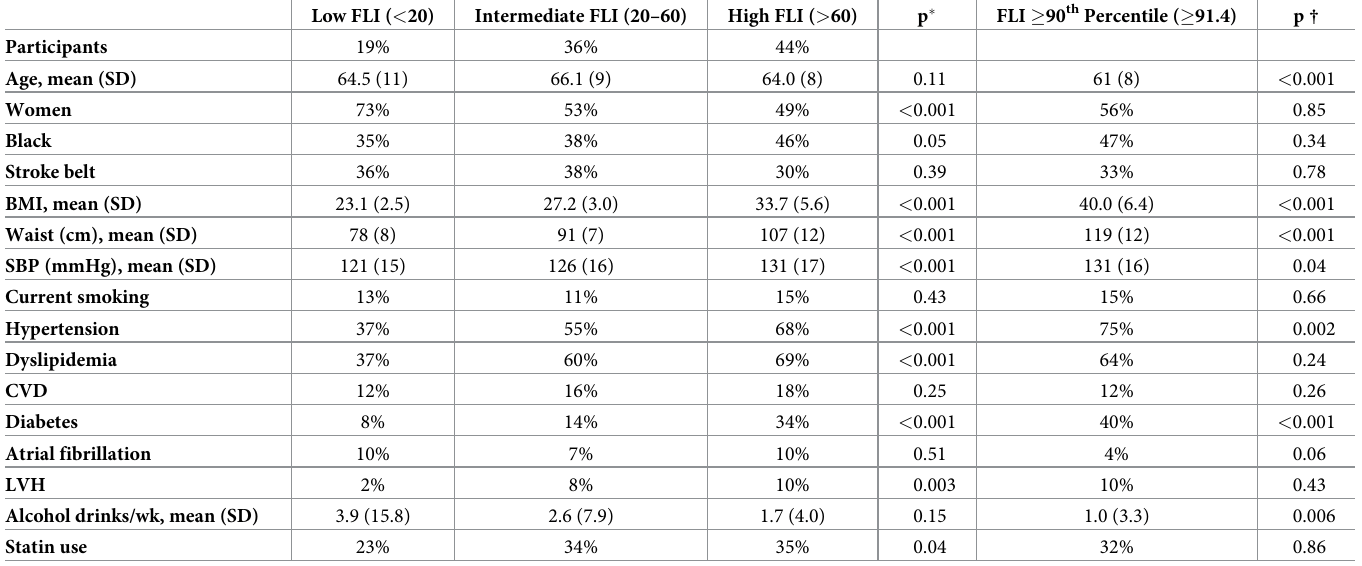
Table 1. Baseline characteristics by FLI score in the cohort random